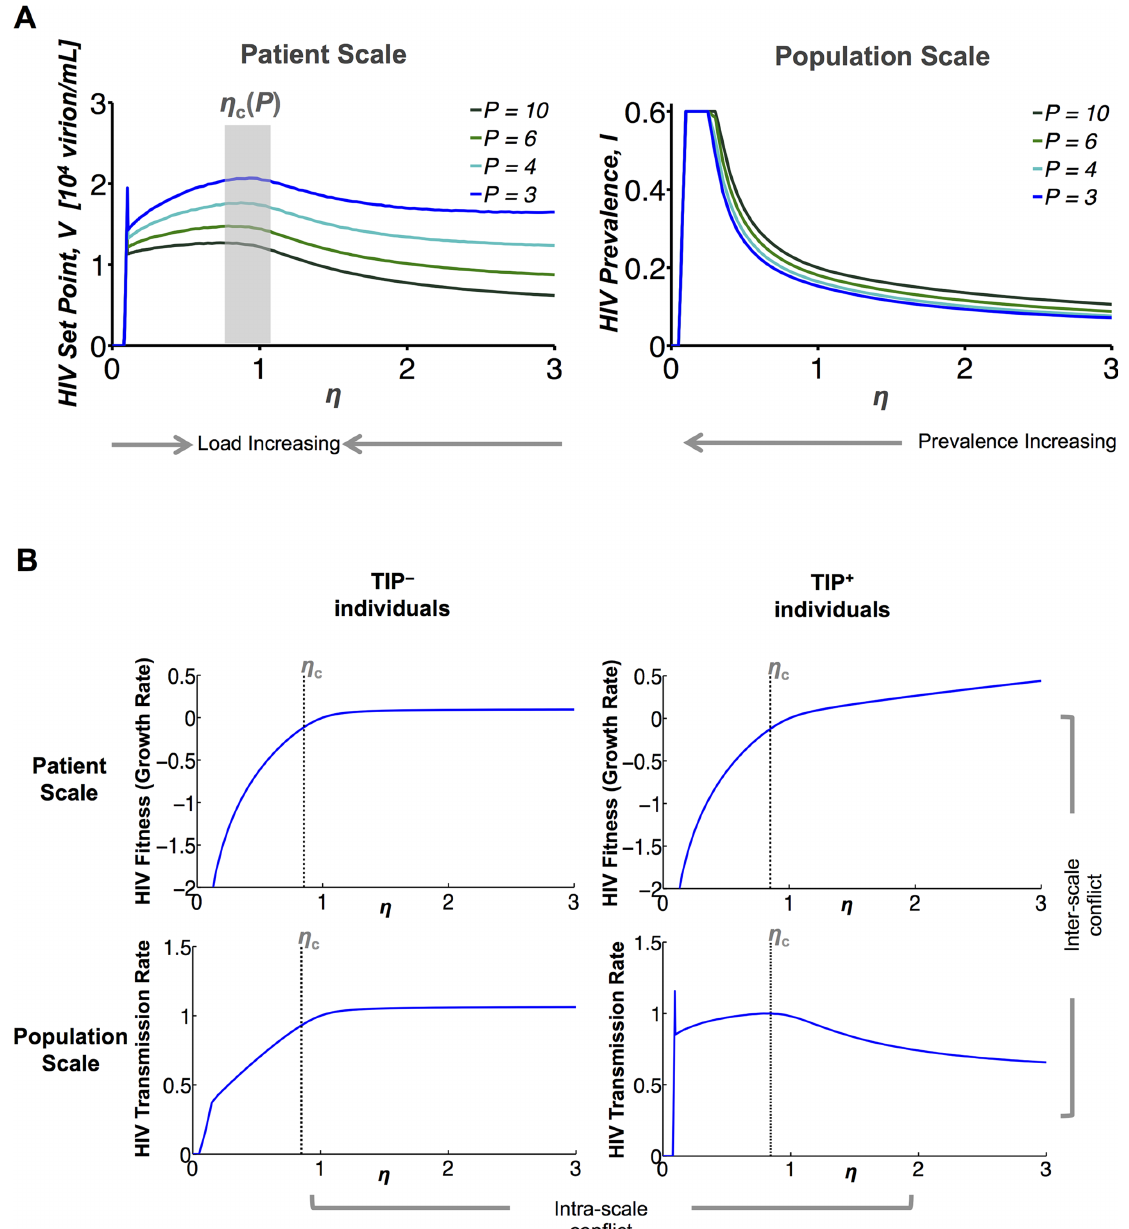
Fig 2. TIP-resistant HIV mutants face conflicting selection pressures. (A) Normalized HIV set-point viral load within individual patients (left) and steady- state HIV prevalence in a high-risk population (right) as functions of P and η . Only the TIP stability region of P > 3 is shown; S2 Fig shows the results when P < 3. For all P > 3, HIV ’ s set point peaks once at low η (cid:4) 0.1 (near the HIV extinction regime), and again at a single critical value of η (cid:4) 1 termed η c ( P ) (translucent gray box). Since they increase HIV set points, both mutants with values of η closer to η c (compared to wild type) or mutants close to ~0.1 are termed virus-load increasing mutants . In contrast, HIV prevalence always increases as η decreases. Mutants with lower values of η (compared to the wild- type) are thus termed prevalence-increasing mutants. Collectively, virus-load increasing mutants and prevalence-increasing mutants form the two classes of ‘ resistant ’ HIV mutants tracked in this study. B) Divergent selection pressures acting on η at the individual-patient scale (top panels) and the population scale (bottom panels). At the individual-level, relative fitness represents the relative rate of expansion or contraction of HIV mutants (via the effective selection coefficient; see Eq. 97 in S1 Text). At the population level, transmission rates are calculated from the individual patient viral set-point (see Eqs. 62 – 65 in S1 Text). Both fitness and transmission rates are normalized to their values at η c . In all plots, P = 6 (the features are qualitatively similar for all P > 3, S3 Fig). At the individual-patient scale, HIV fitness always increases as η increases — whether or not an individual has been exposed to TIP. However, in TIP-treated (TIP + ) individuals, HIV ’ s population-scale transmission rate decreases as η increases above η c (because increasing η also increases TIP production). The result is an inter-scale conflict , as divergent selection pressures at the individual-patient and population scales drive η in opposing directions in TIP + individuals. Further, in TIP − individuals, HIV ’ s transmission rate increases whenever η increases. As a result, the presence of TIP + and TIP − individuals exerts opposing selection pressures on the value of η . We term this population-level conflict to be the intra-scale